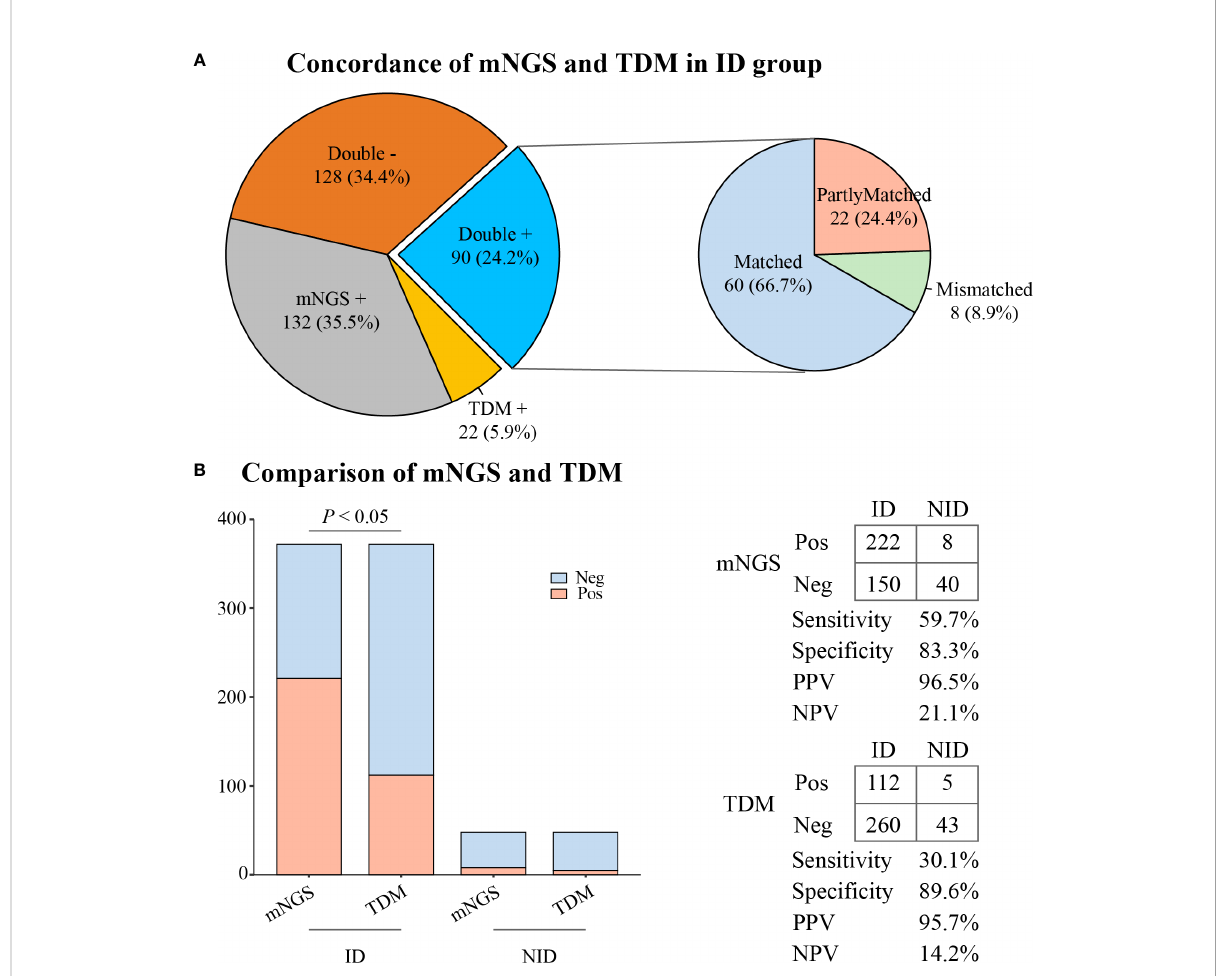
FIGURE 3 The concordance and diagnostic ability of mNGS and TDM. (A) Concordance of mNGS and TDM in the ID group. (B) Comparison of diagnostic ability between mNGS and TDM. mNGS, metagenomic next-generation sequencing; TDM, traditional diagnostic method; ID, infectious disease; NID, non-infectious disease; Pos, positive; Neg, negative; PPV, positive predictive value; NPV, negative predictive value.